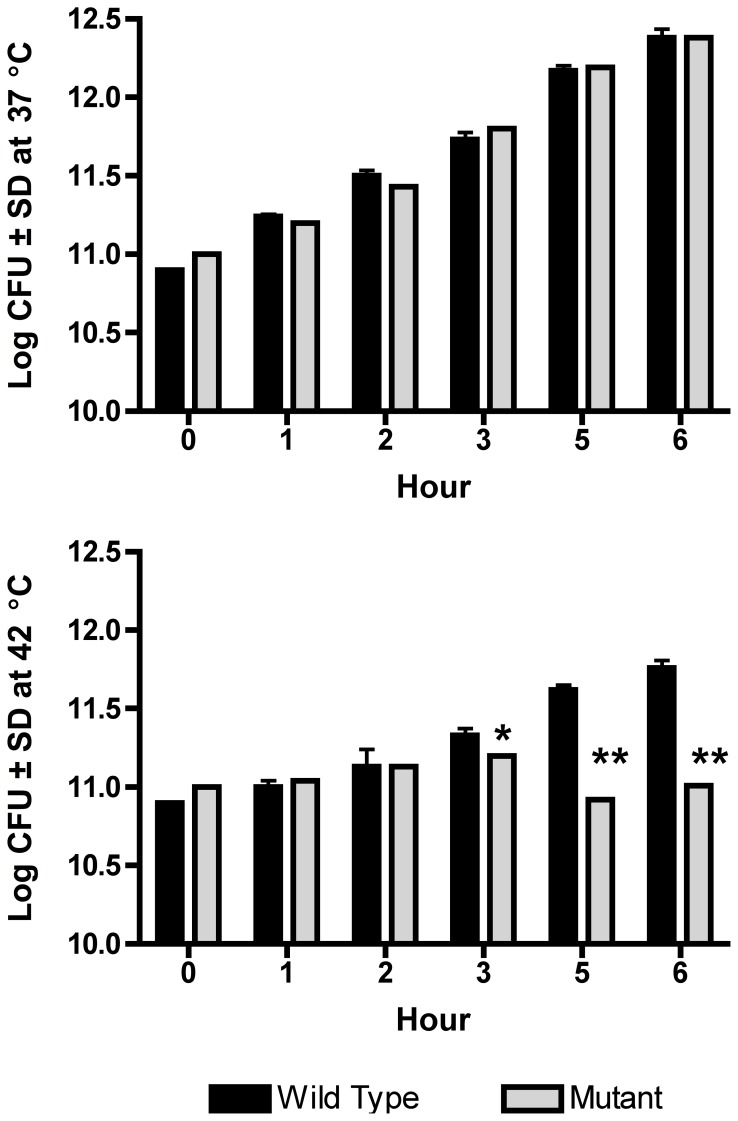
Heat shock response in the Mycoplasma mycoides capri GM12 wild type and the ctpA(clpP)::tetM mutant.No differences were observed between the mutant and wild type when grown at 37°C. At 42°C, the mutant exhibited significantly reduced growth at 3 hr (*, P<0.01) and subsequent time points (**, P<0.001) than did the wild type.